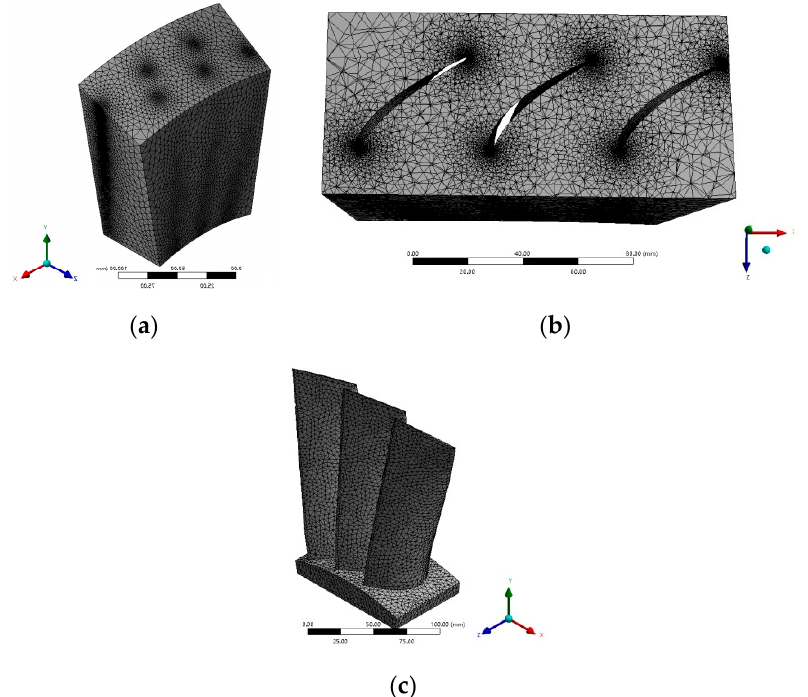
Figure 4. Meshes of the blade and the flow field model. ( a ) Mesh of the whole flow field model; ( b ) cutaway view of the mesh of the blade model; ( c ) mesh of the blade model.